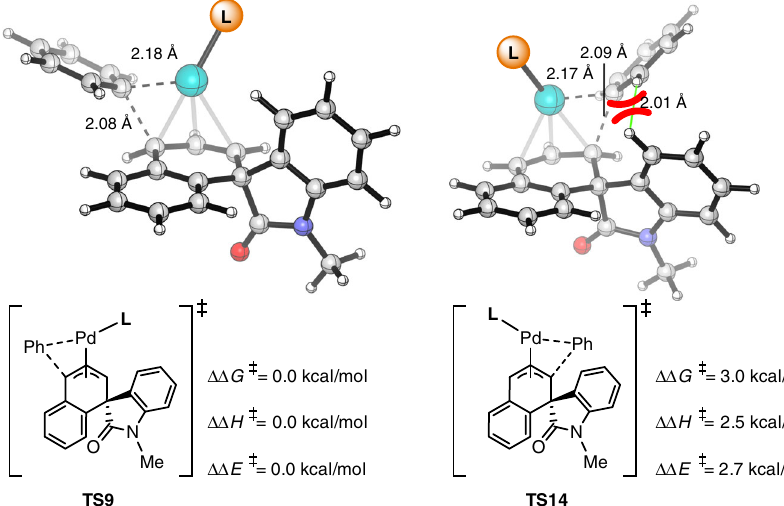
Fig. 6 Theoretical calculations. DFT-computed free energies of the regioselectivity-determining reductive elimination transition states ( L = L5